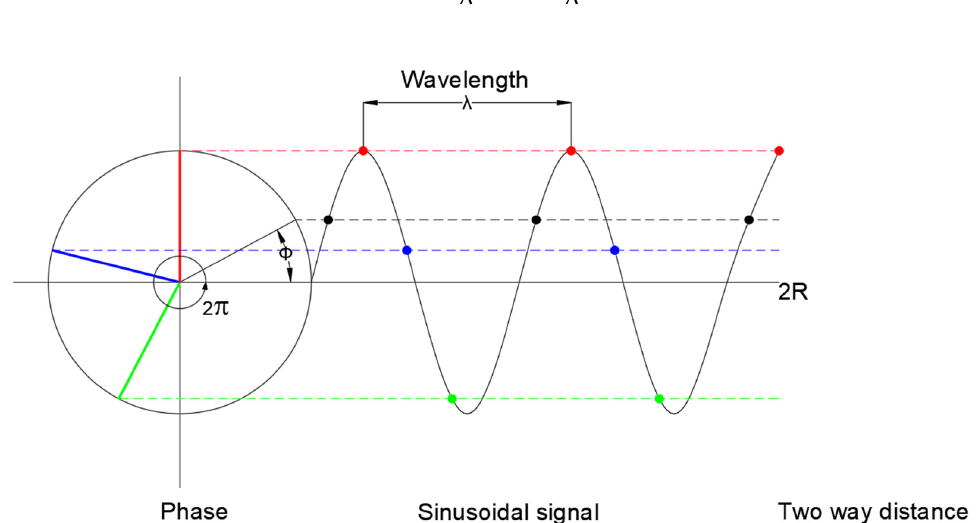
Figure 3. Phase difference. Source: ESA-TM19 InSAR Principles.